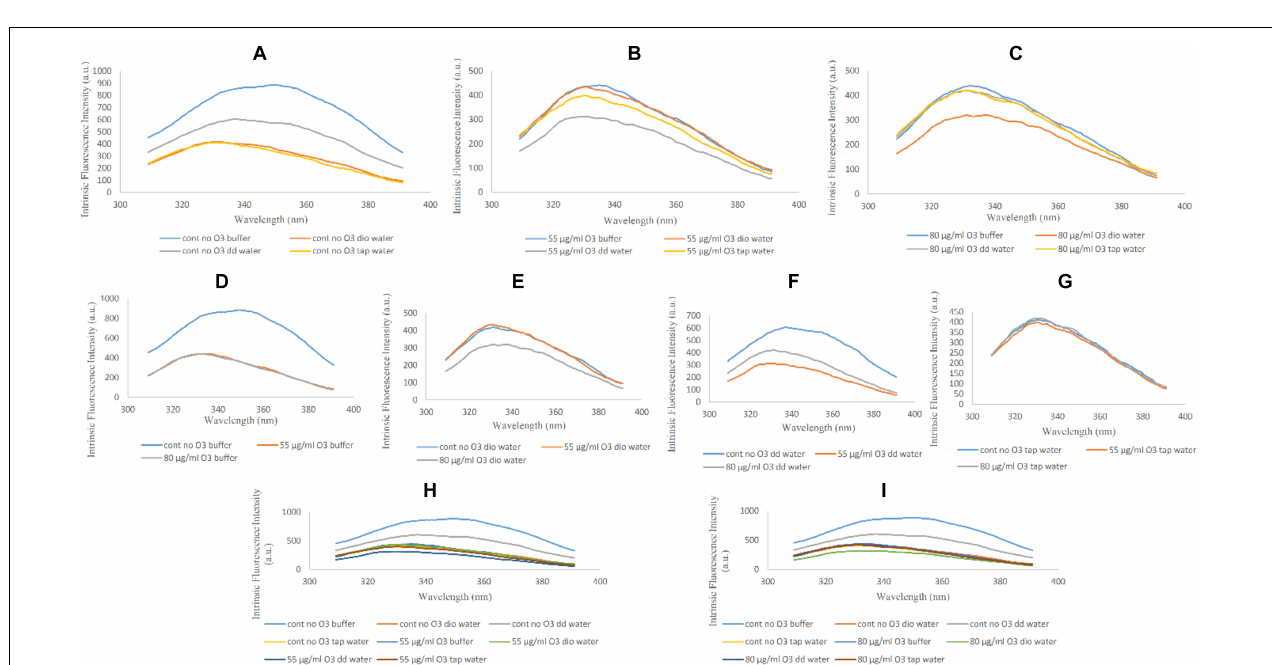
FIGURE 1 | The effect of syringe volume on human Hb precipitation during ozonation. Top row: Hb ozonated at 55 µ g/ml ozone (samples 5 to 8) and 80 µ g/ml of ozone (samples 9 to 12) with the larger 10 ml syringe. Bottom row: Hb ozonated at 55 µ g/ml ozone (samples 5 to 8) and 80 µ g/ml of ozone (samples 9 to 12) with the smaller 5 ml syringe. Samples 1 to 4, 5 to 8 and 9 to 12 are Hb in phosphate buffer, deionized water, double distilled water and tap water, respectively, whereas samples 1–4 are non-ozonated control samples.